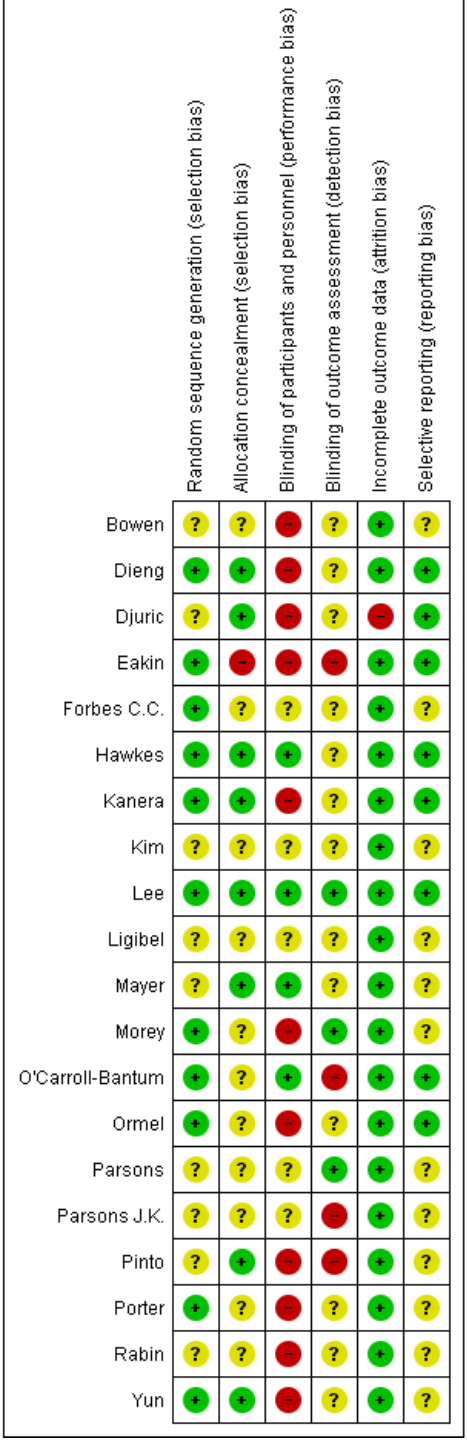
Figure 2. Risk of bias summary of the included randomized control trials using the Cochrane Collaboration risk of bias